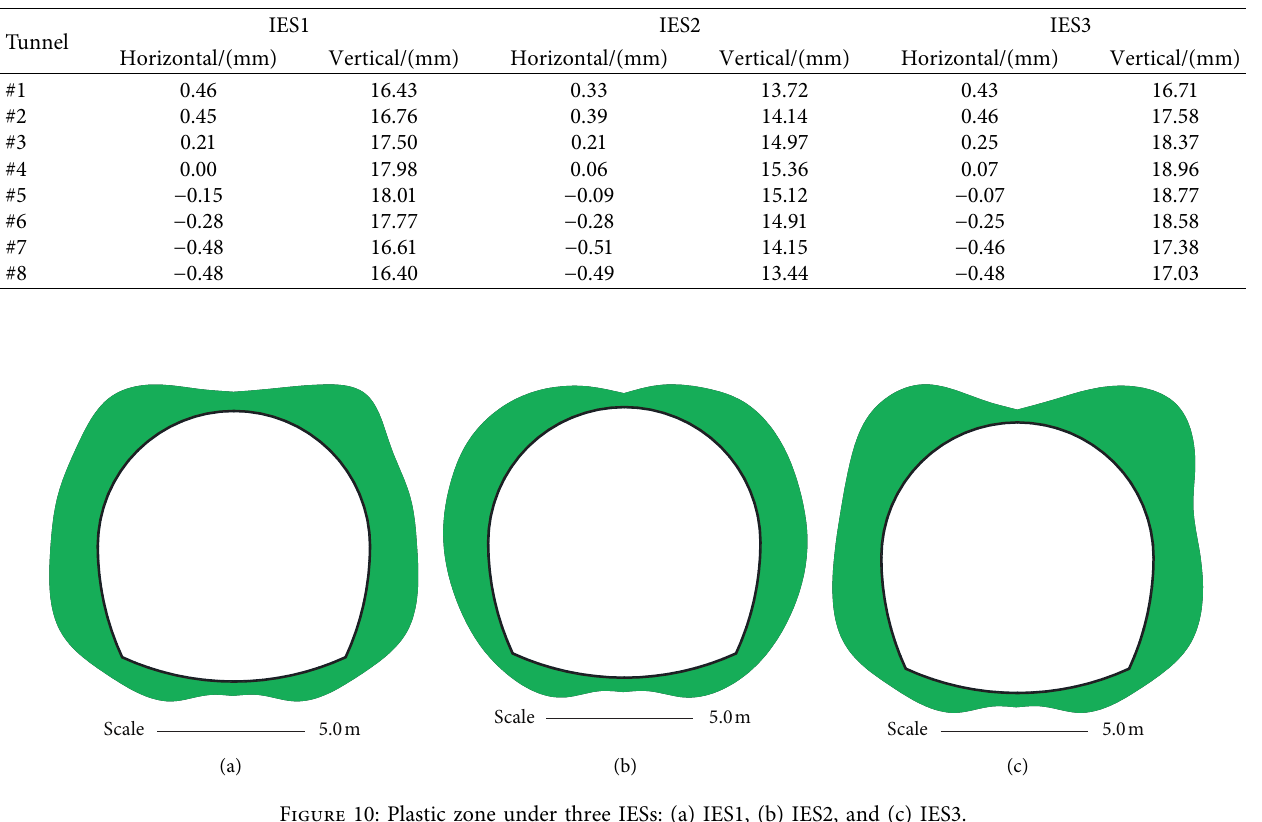
Table 4: Total displacements at the top point under different IESs.